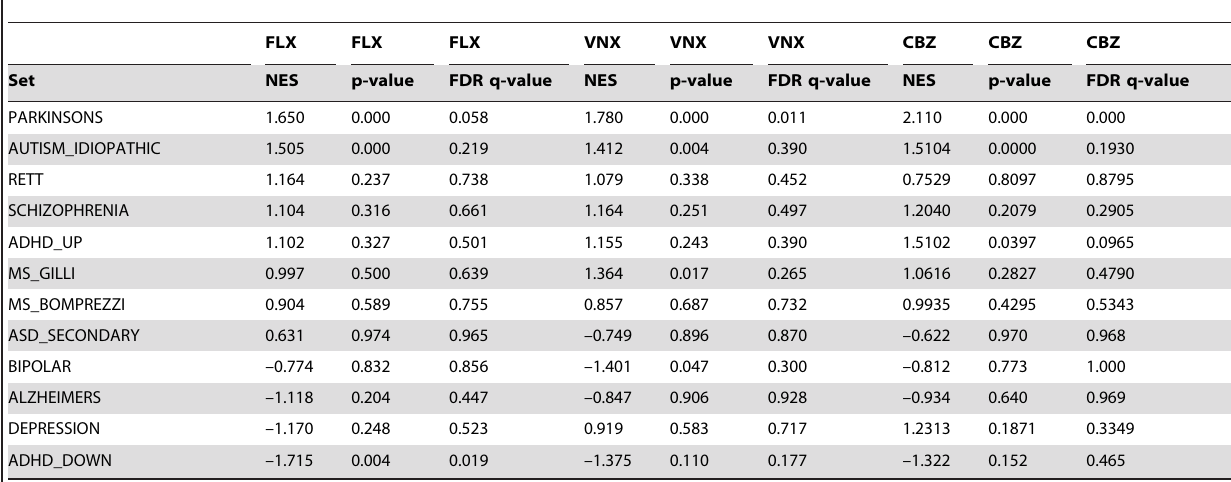
Table 7. Single drug treatments & ND